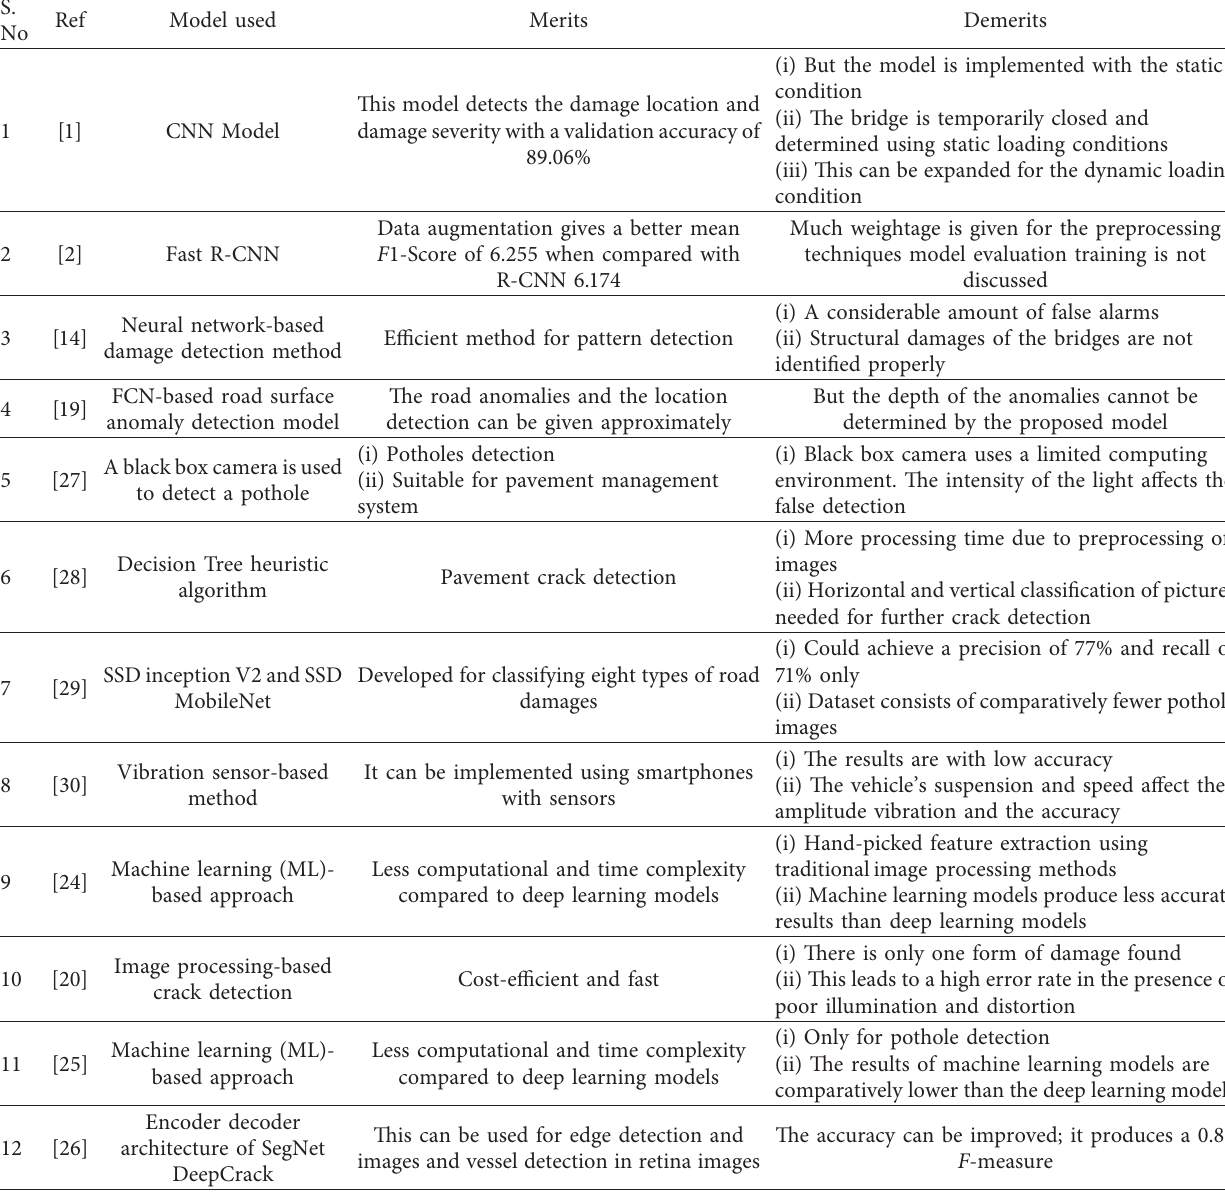
Table 1: Overview of the literature survey.